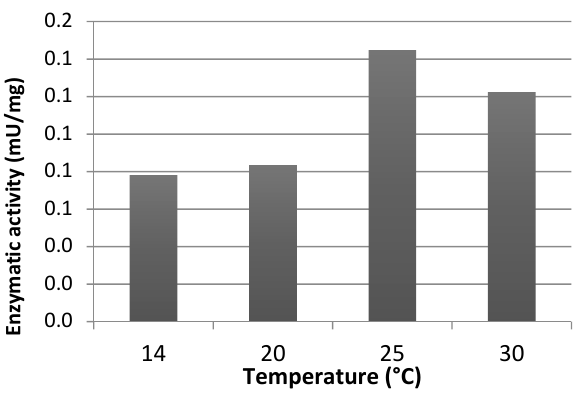
Figure 4. Effect of the temperature on carbamoylase activity. GTX5 was used as a substrate.